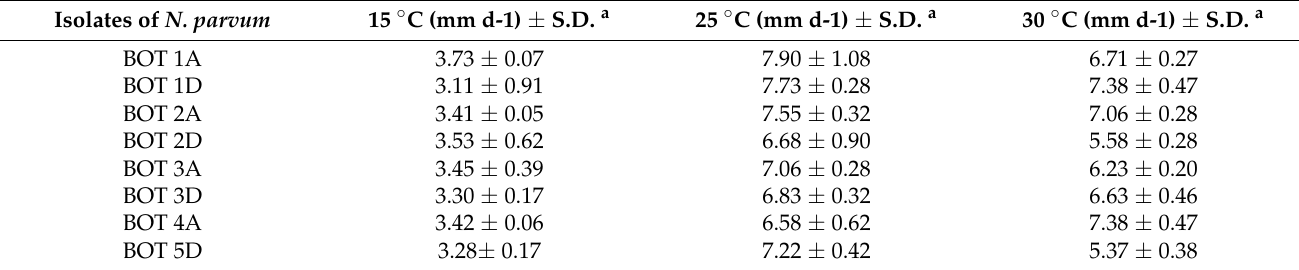
Table 3. Mean radial growth rates of colonies of representative Neofusicoccum parvum isolates of different geographical origin on PDA at three different temperatures, as determined after 3 d of incubation. Isolates of N.